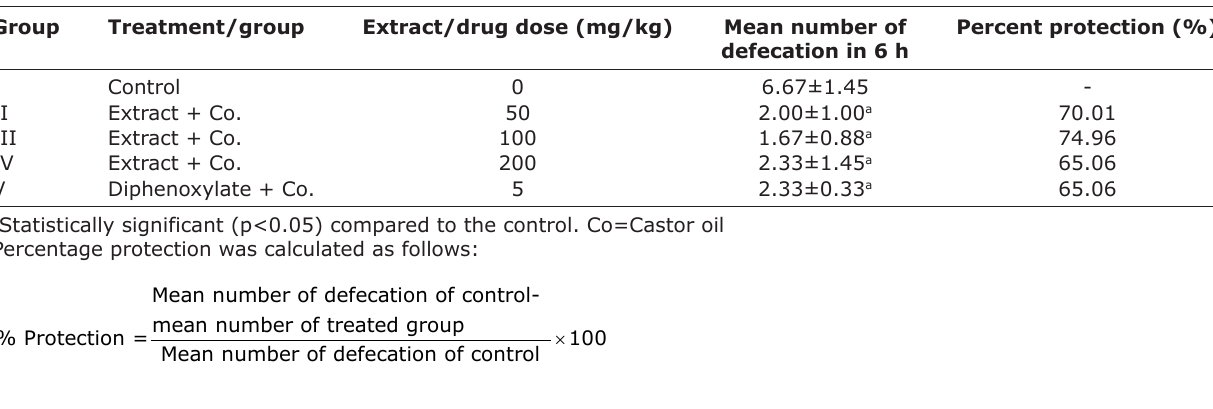
Table-2: Effect of aqueous root bark extract of Byrsocarpus coccineus on charcoal gastrointestinal transit in albino rats. Group